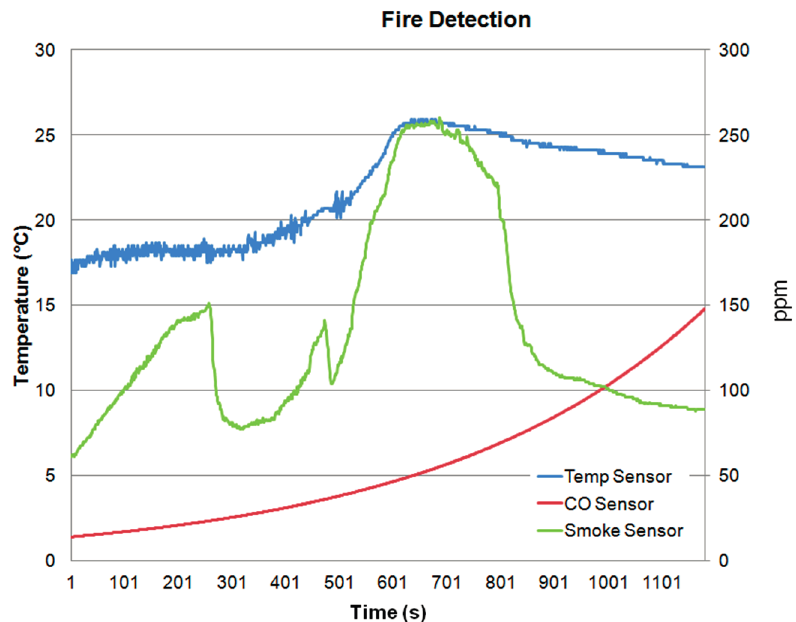
Figure 12. Fire detection.